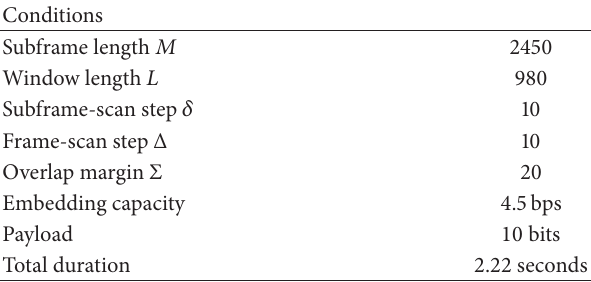
Table 7: Simulation conditions for the self-synchronized SSA-based audio watermarking